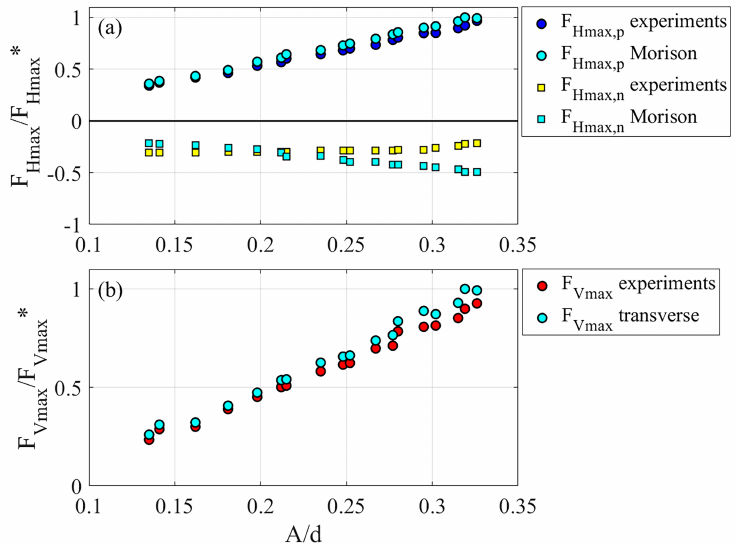
Figure 9. Comparison between experimental and calculated maximum positive and negative wave forces vs. A / d . ( a ) Horizontal force; ( b ) vertical force.